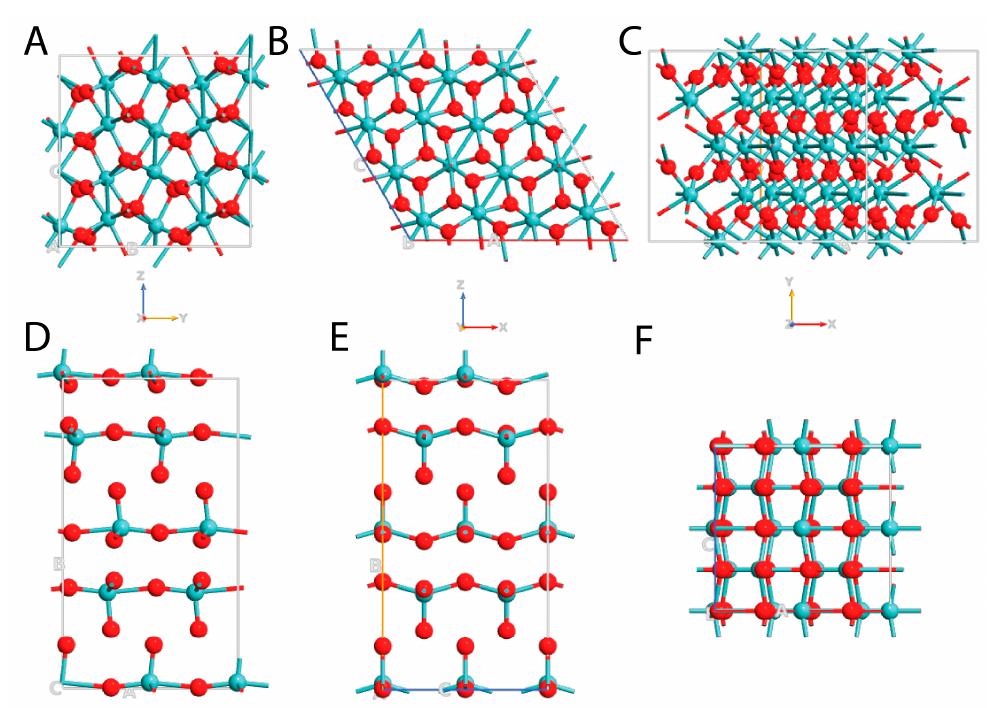
Figure 1. Schematic representation of all the examined systems: monoclinic MoO 2 from yz plane ( A ), xz plane ( B ), and xy plane ( C ); orthorhombic MoO 3 from yz plane ( D ), xz plane ( E ), and xy plane ( F ). Mo atoms are depicted in light blue and O in red.